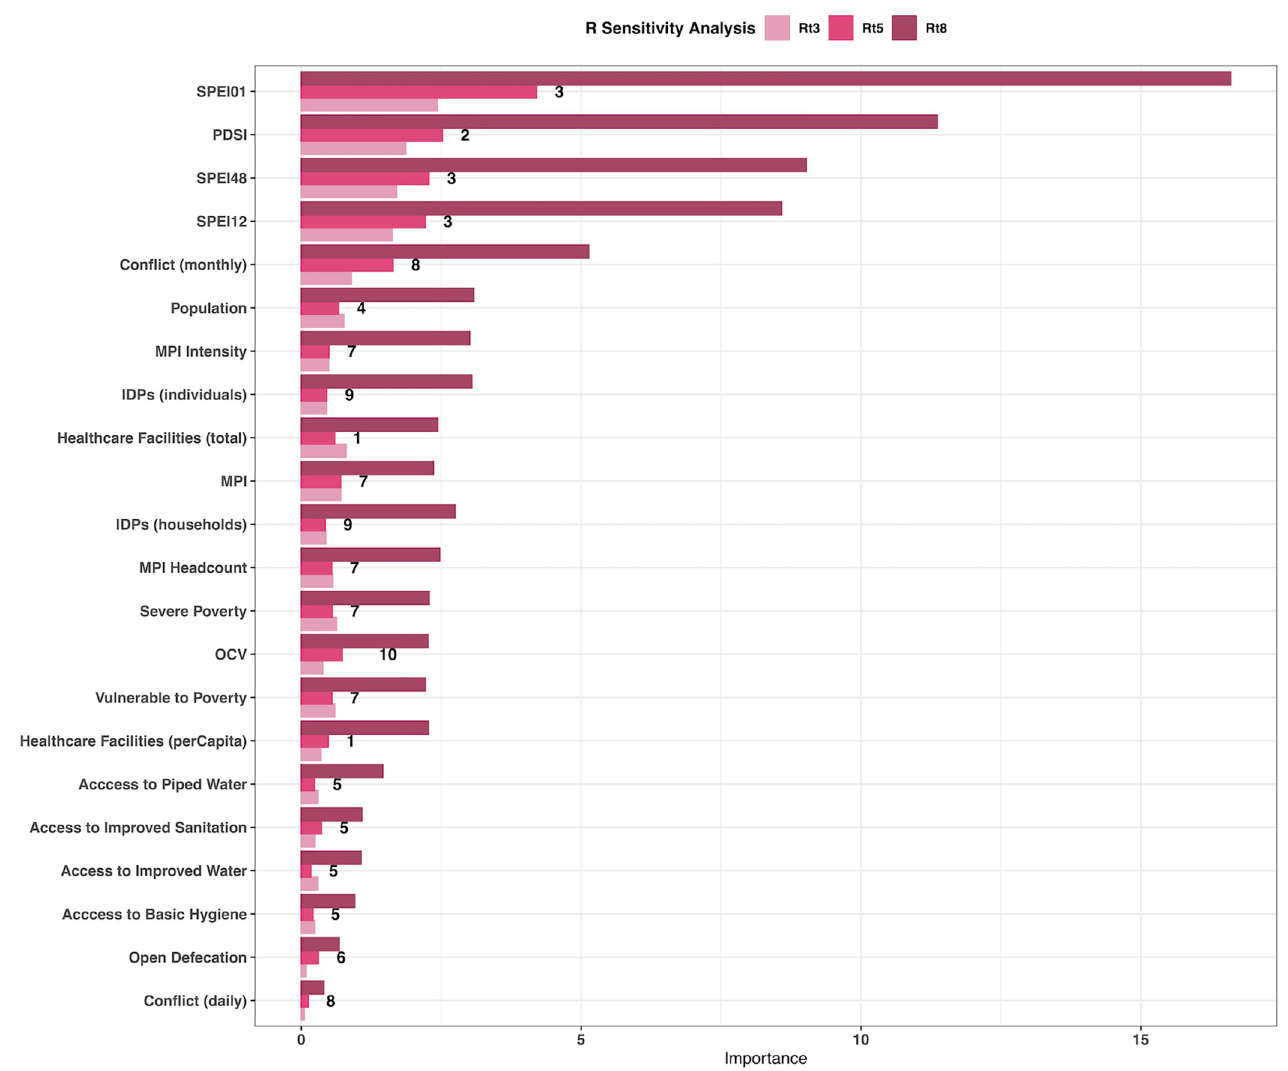
Fig 4. The variable importance for the 21 tested for inclusion in the best fit model. All three serial interval values tested are shown (Rt3–3 days, Rt5–5 days, Rt8–8 days) and the numbers represent the clusters. Variable importance is measured through node impurity (see Methods for details). SPEI01, 12, 48— Standardised Precipitation Index calculated on 1, 12 and 48 month scale. PDSI—Palmers Drought Severity Index. MPI—Multidimensional Poverty Index. IDP–Internally Displaced Persons. OCV–Oral Cholera